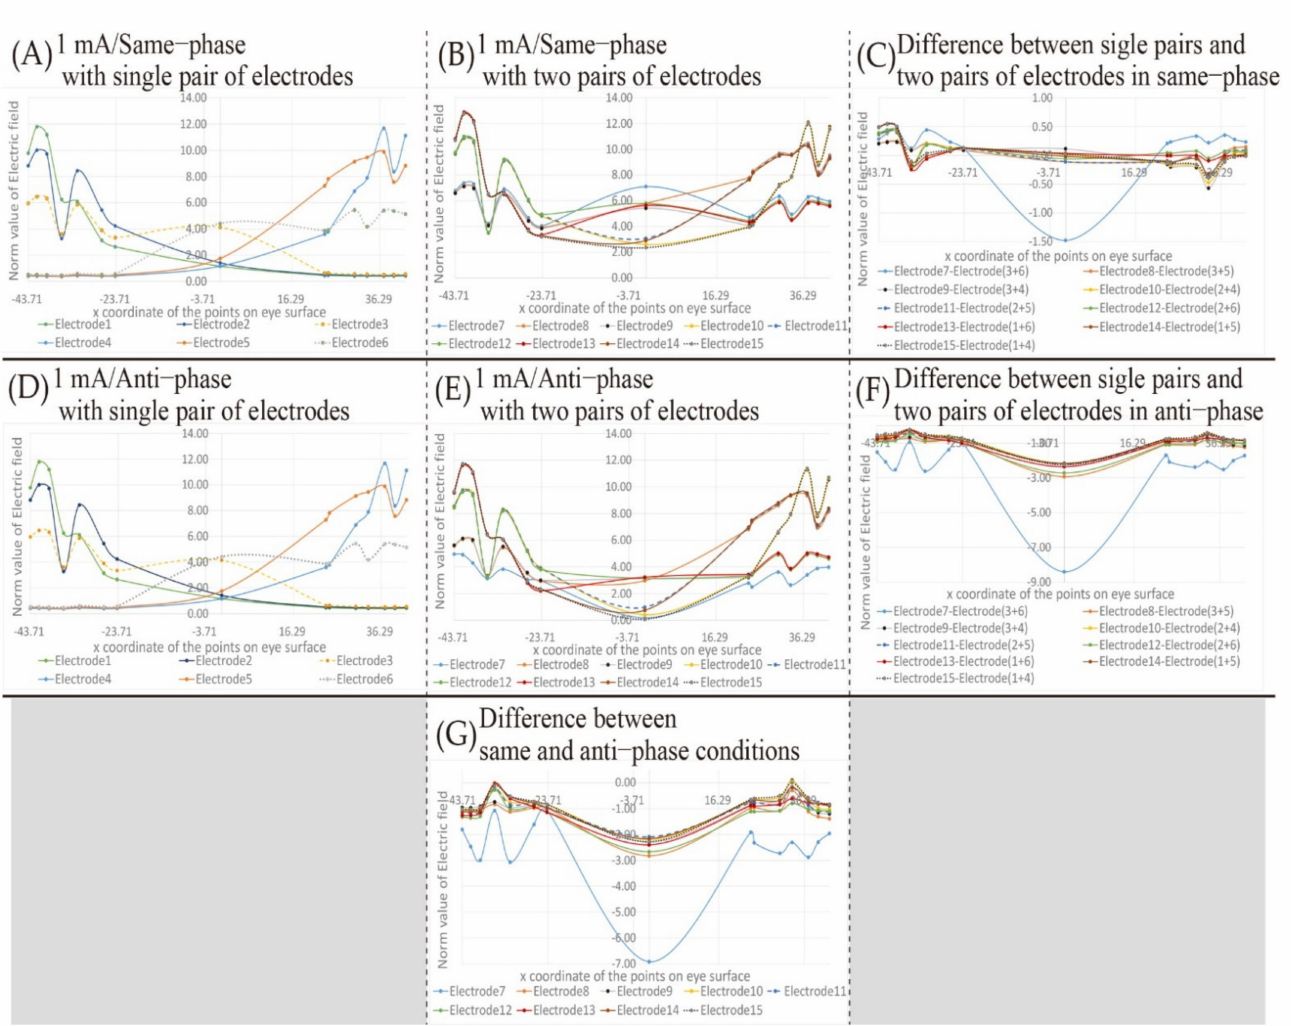
Figure 7. The transition of the electric field value on the eyeball surface with the electrode placement that is gradually separated from each other in 1 mA; ( A ) norm value of electric field in 1 mA and same-phase stimulus with single pair of electrodes; ( B ) norm value of electric field in 1 mA and same-phase stimulus with two pairs of electrodes; ( C ) difference of norm value of electric field in 1 mA and same-phase stimulus between single pair of electrodes and two pairs of electrodes conditions; ( D ) norm value of electric field in 1 mA and anti-phase stimulus with single pair of electrodes; ( E ) norm value of electric field in 1 mA and anti-phase stimulus with two pairs of electrodes; ( F ) difference of norm value of electric field in 1 mA and anti-phase stimulus between single pair of electrodes and two pairs of electrodes conditions; ( G ) difference of norm value of electric field in 1 mA with two pairs of electrodes between same-phase and anti-phase